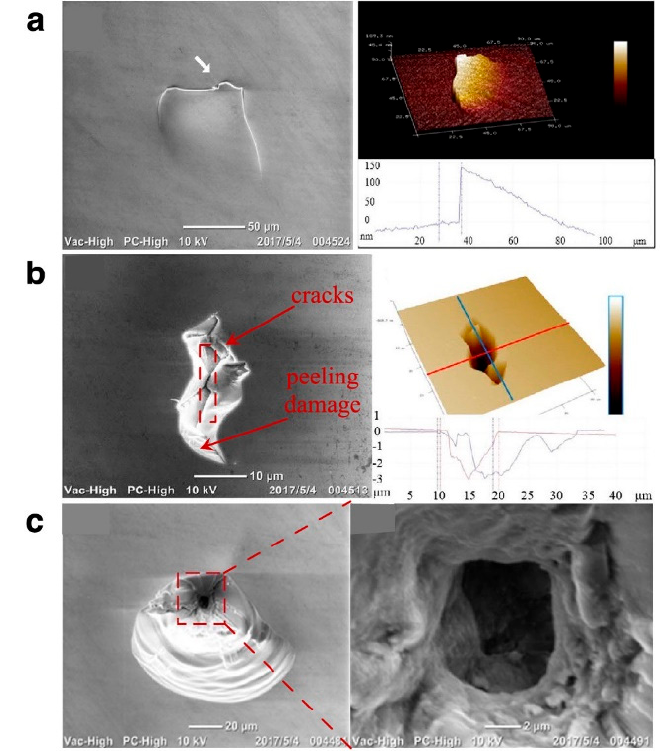
Figure 21. Microscopic images of the typical damage morphology. ( a ) Crack, ( b ) shell, and ( c ) crater. Λ = 351 nm, pulse duration = 5 ns [102].